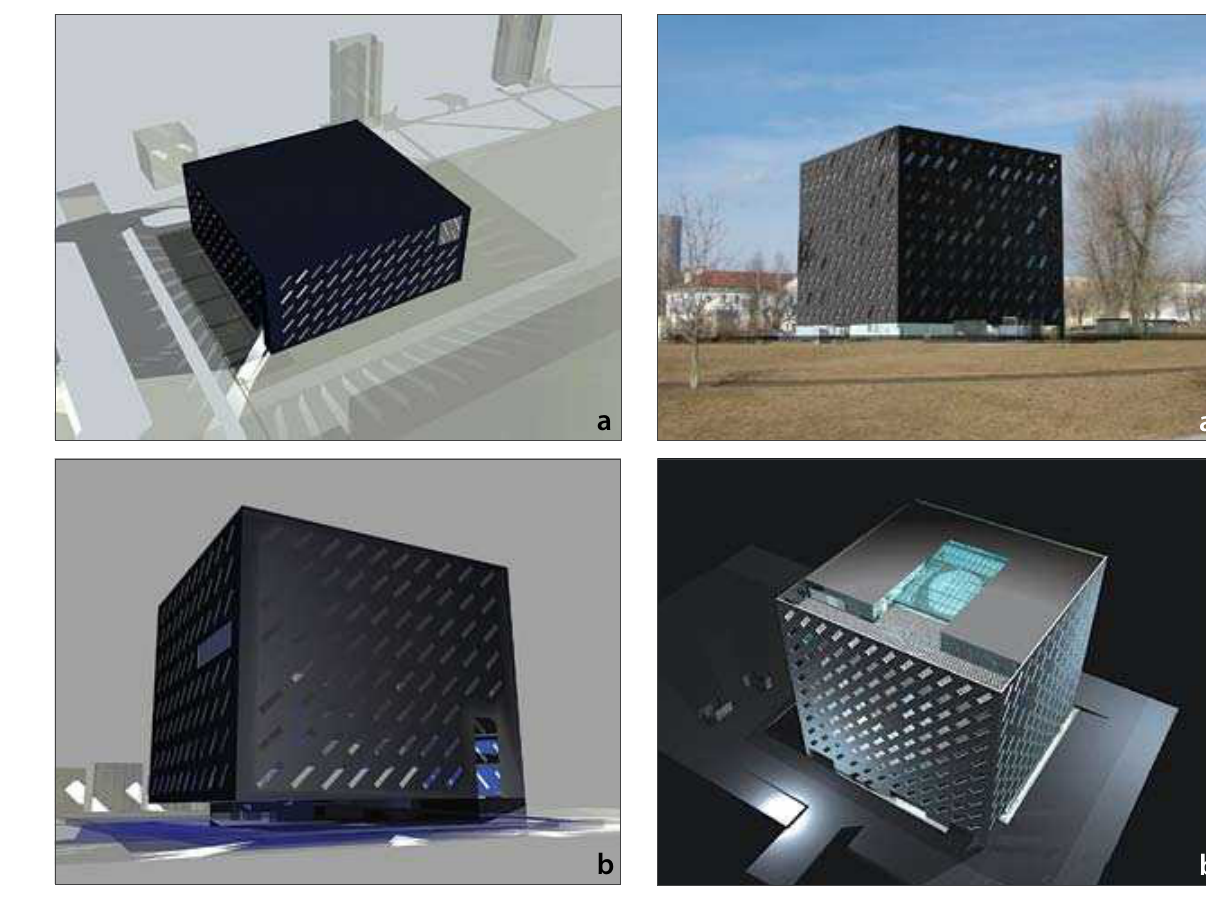
6 pav. Prokuratūrų pastatas (tP vizualizacijos) (a, b), Vilnius. archit. k. Lupeikis, 2006 m. Fig. 6. Prosecutor's Office building (tP visualizations) (a, b),